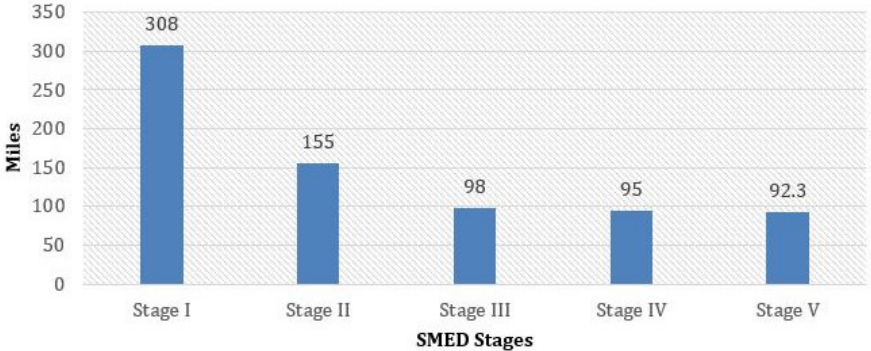
Figure 7. Distance traveled by